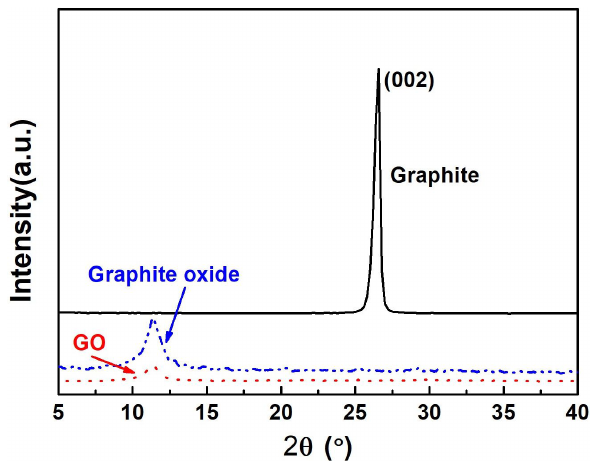
Figure 3: XRD patterns of the graphite, graphite oxide and GO